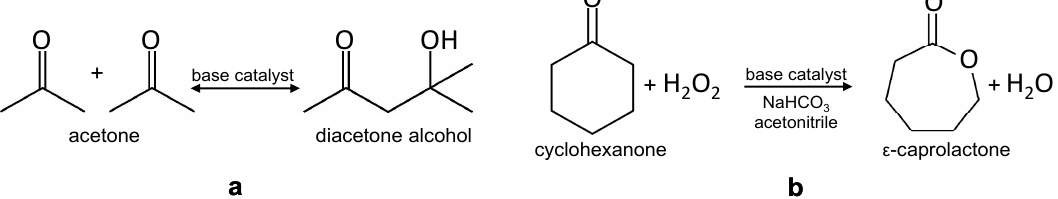
Figure 11. ( a ) Aldol self-condensation of acetone, ( b ) Bayer-Villiger oxidation of cyclohexanone to ε -caprolactone with H 2 O 2 as an oxidant.